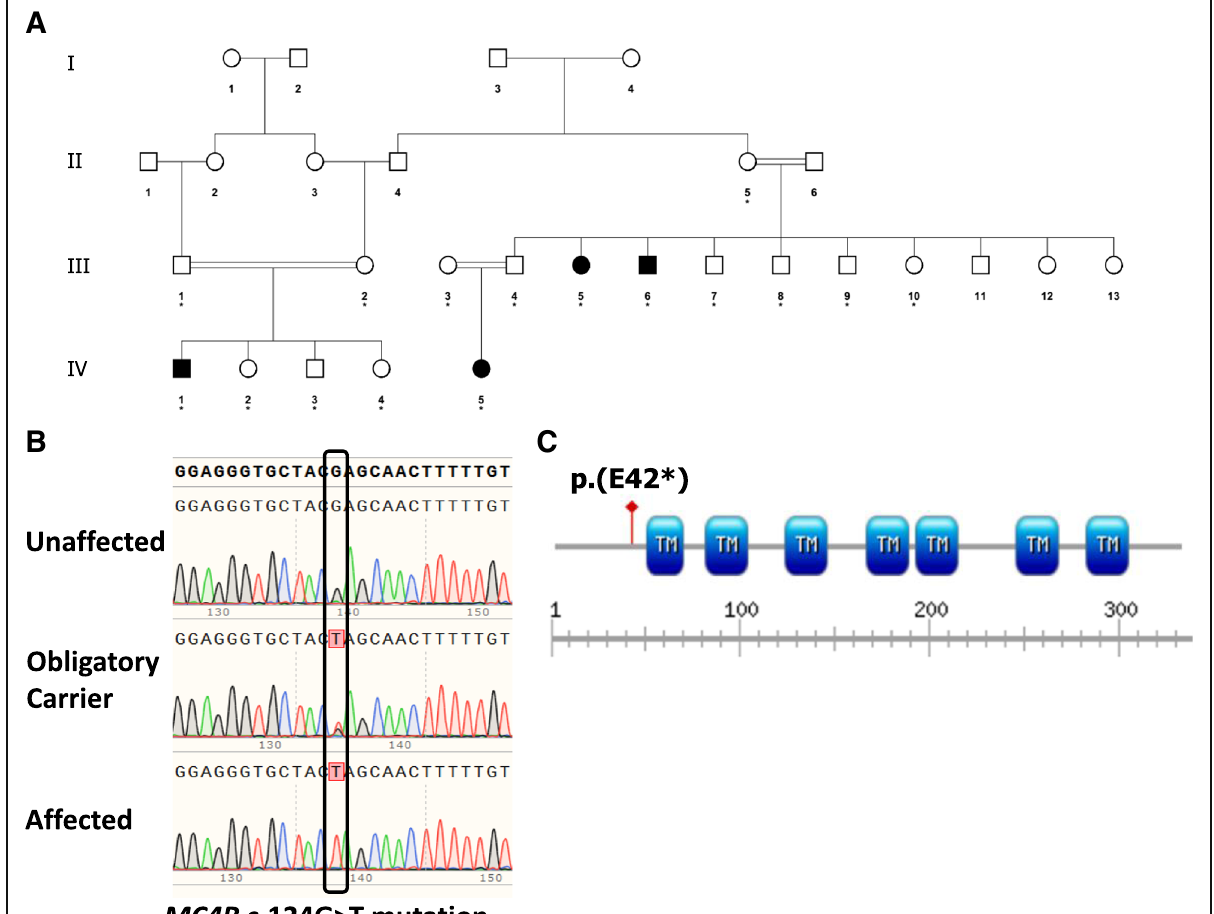
Fig. 1 Pedigree of the studied kindred and the MC4R mutation. a Pedigree of a consanguineous Bedouin family presenting with a phenotype of autosomal recessive early-onset obesity (individuals with phenotypic morbid obesity are marked as affected; asterisk marks individuals whose DNA was available for analysis). b The c.124 G > T, p.(E42*) MC4R mutation: Sanger sequencing of an unaffected individual (III:7), an obligatory carrier (II:5) and a morbidly-obese affected individual (IV:1). c Schematic representation of the p.(E42*) mutation in MC4R predicted to truncate almost 90% of the protein (TM, Transmembrane